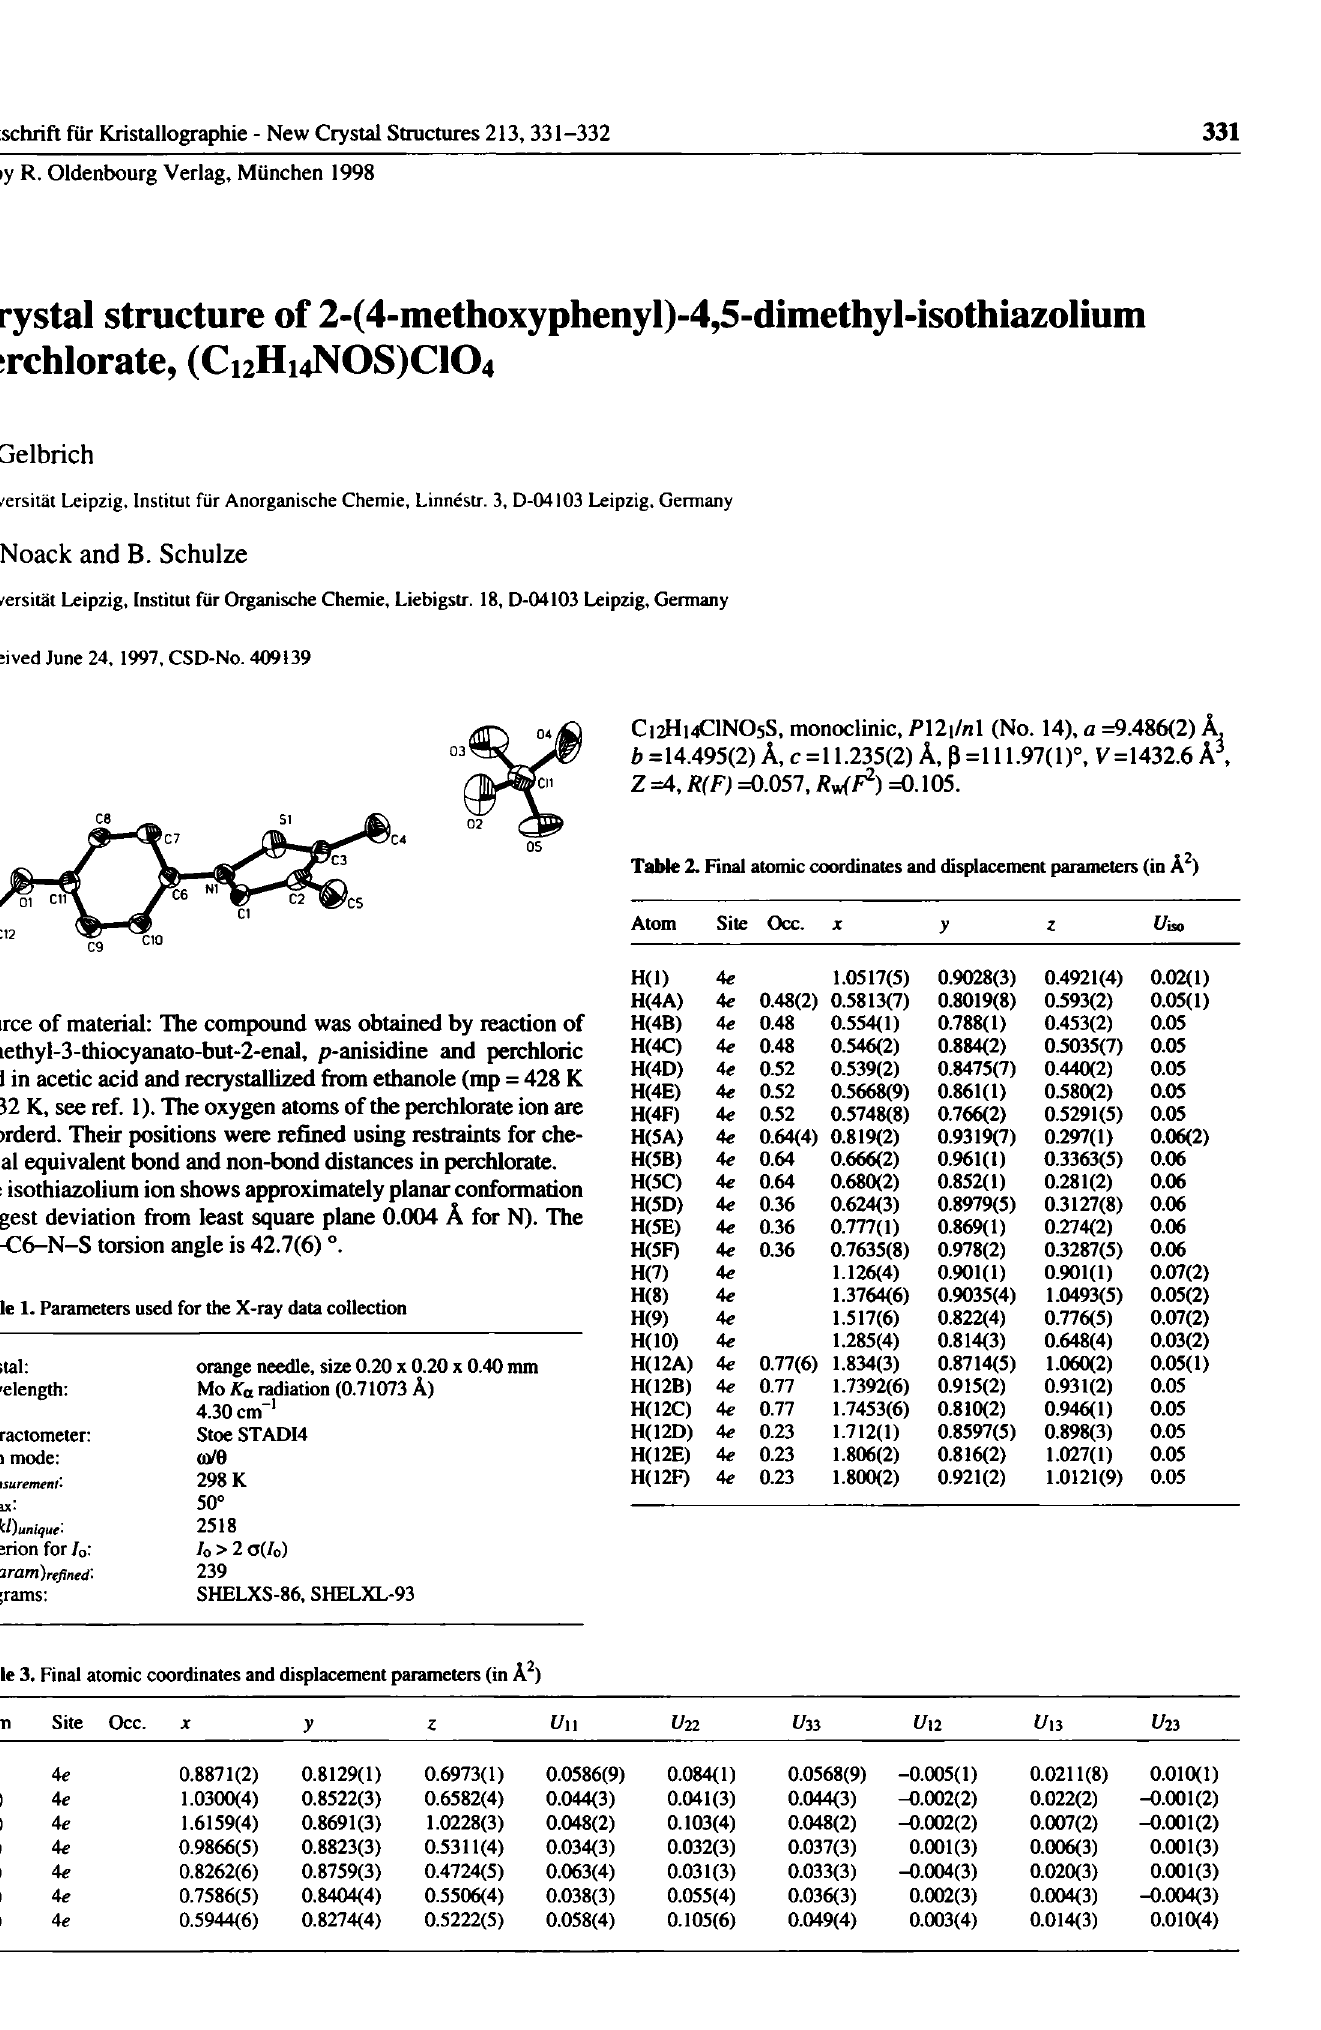
Table 1. Parameters used for the X-ray data collection Crystal: